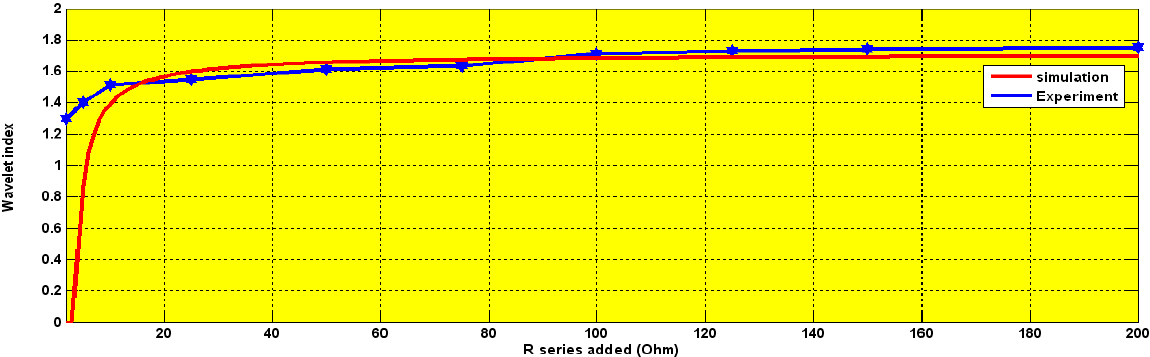
Figure 21. Experimental and simulation wavelet index for series Rs (2–200) Ohm at 900 rpm.